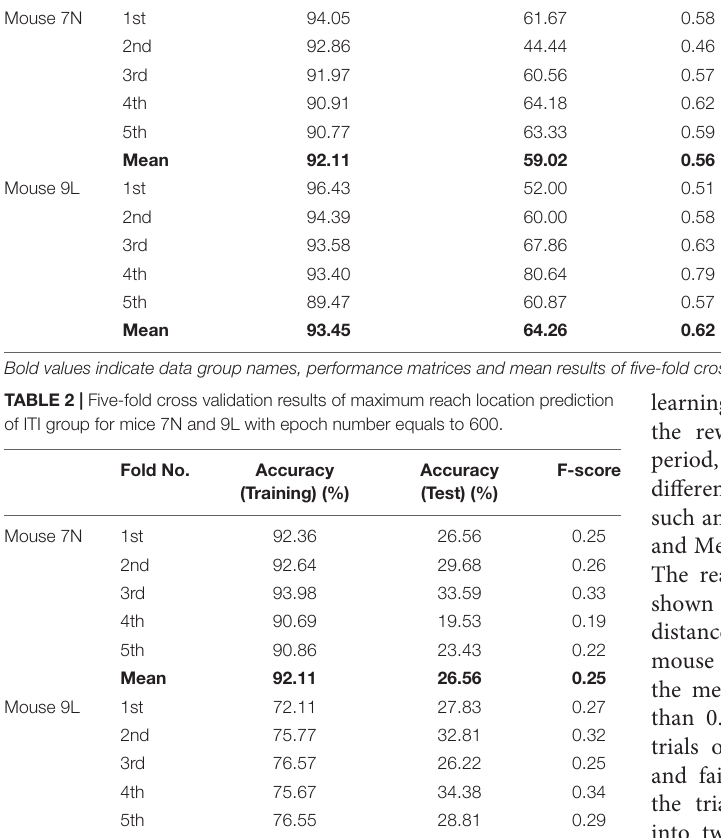
TABLE 1 | Five-fold cross validation results of maximum reach location prediction of the RFA post-cue and ITI group for mice 7N and 9L with epoch number equals to 300. RFA post-cue RFA ITI Fold No.